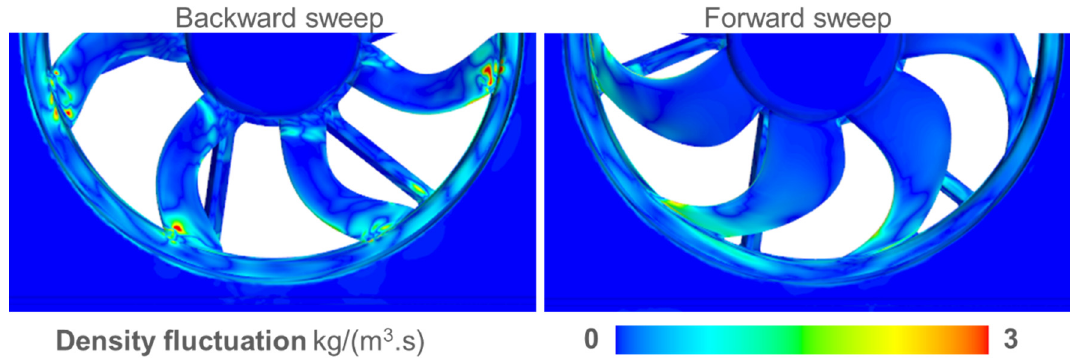
Figure 16. Comparison of density fluctuations on the fans.